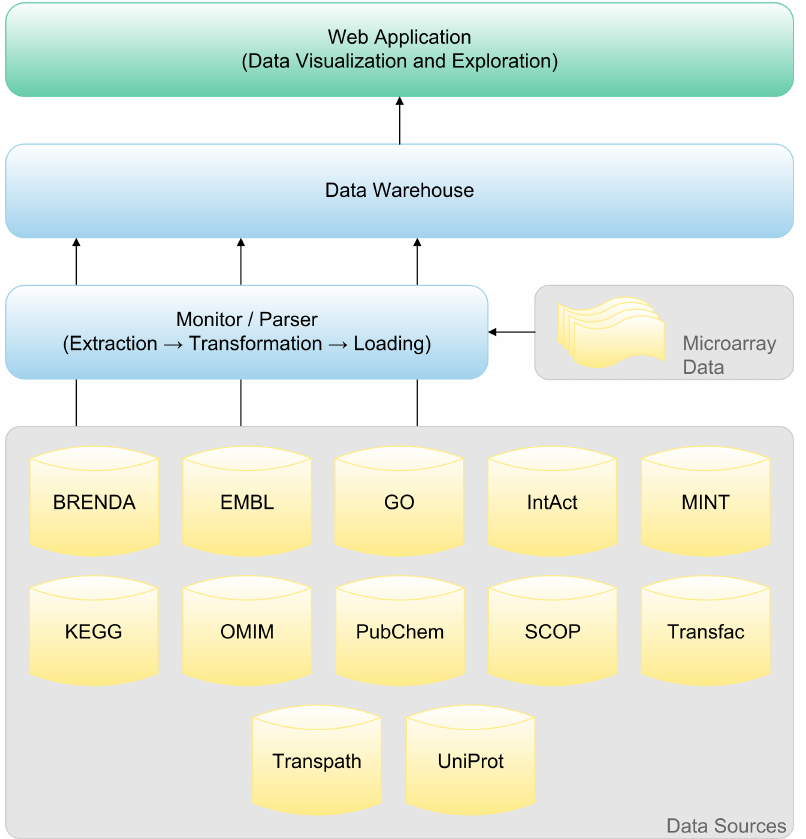
Figure 1: Schematic representation of the CardioVINEdb 4-layer system architecture from the original heterogeneous data sources to the web application